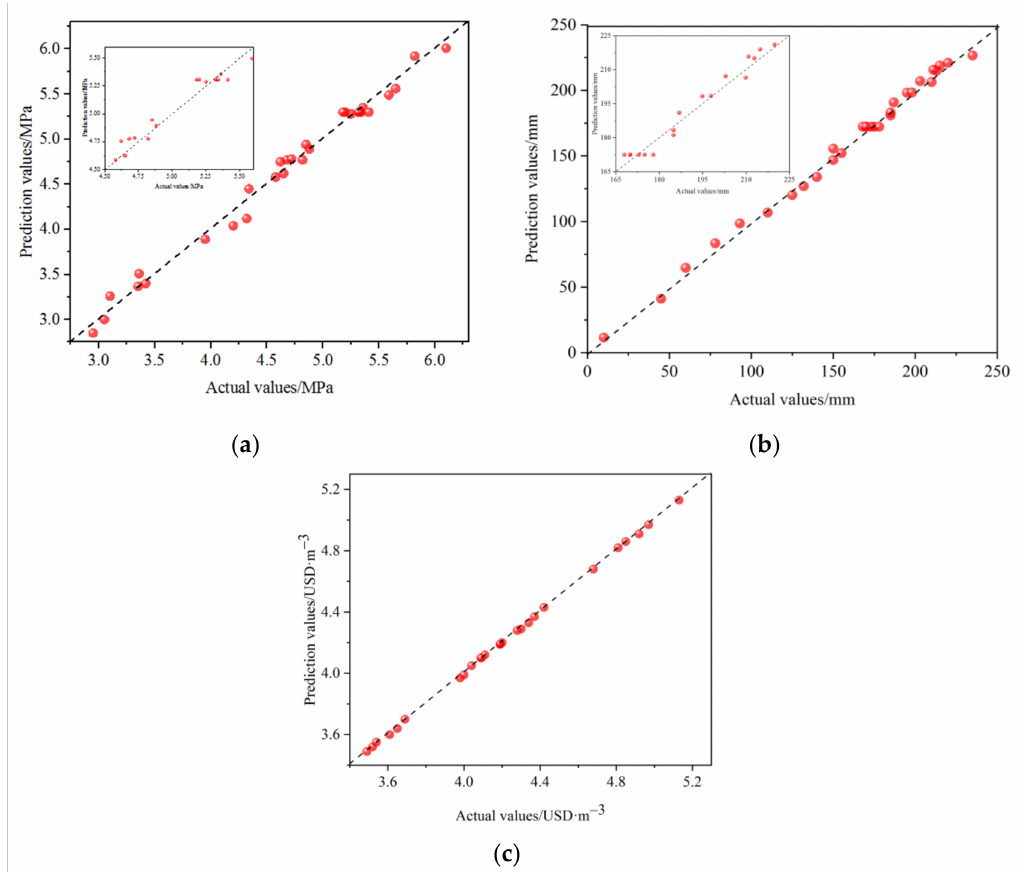
Figure 4. Prediction value and actual value for ( a ) 28-dUCS, ( b ) slump, and ( c ) cost. According to the data in Table A2 (in Appendix B), the p -value of the 28-dUCS regres- sion model is less than 0.0001, which shows that the model is very significant. In addition, the missing fitting term p = 0.1391 (greater than 0.05) and the variance of 0.9887 both indi- cate that the regression model fits well. The influence of factors A , B , C , and D for 28-dUCS is very significant; the order of influence is D > B > C > A . In the interaction, the p -values of the AB , AC , and BD items are all less than 0.05, and the effect for 28-dUCS is significant. As an example, Figure 5 shows a 3D map of the response surface of the interaction between AC and BD . In Figure 5a, with an increase in A and C , the 28-dUCS response surface curvature (intensity change rate) presents a trend of first decreasing and then increasing. The 28-dUCS response surface curvature (intensity growth rate) in Figure 5b shows a decreasing trend with a decrease in B and D . The order of interaction between different factors for 28-dUCS is AC > BD > AB > CD > AD > BC